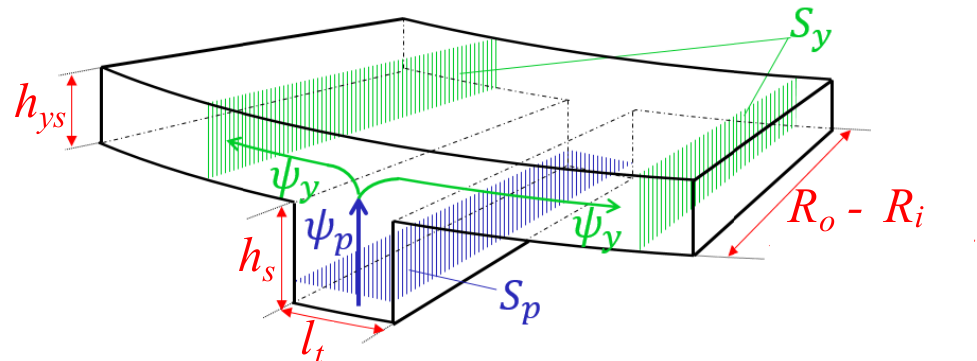
Figure 7. Magnetic flux path in a portion of the stator armature pole of an AFPM